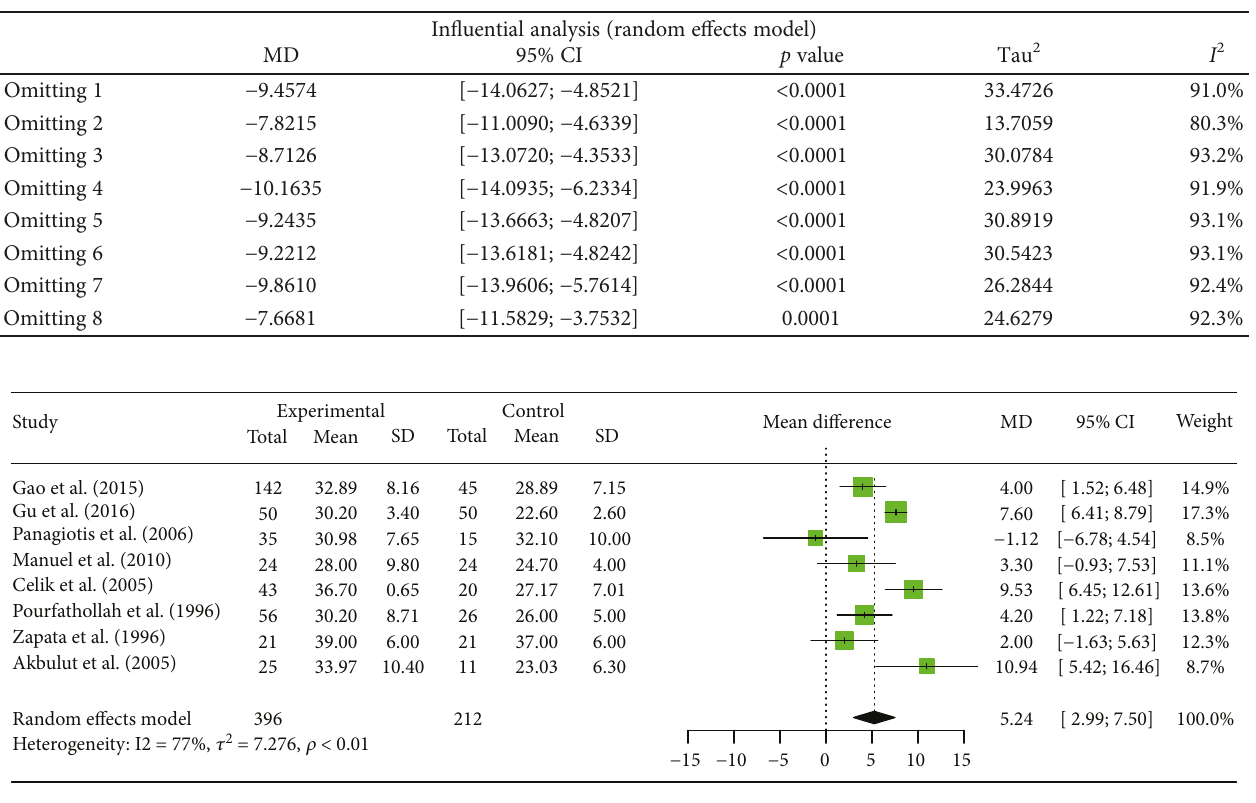
Figure 4: Forest plot of the changes of peripheral blood CD8+ T cell in human brucellosis patients compared with